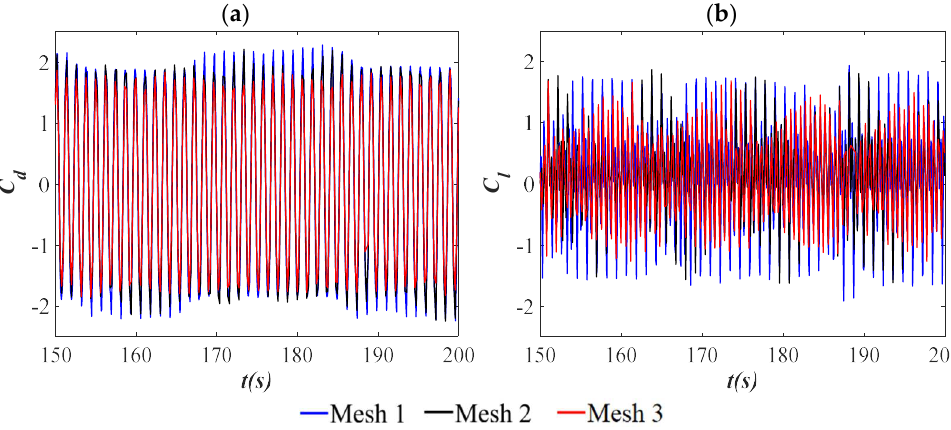
Figure 3. The time-histories of ( a ) C d and ( b ) C l for different meshes: Mesh 1: blue; Mesh 2: black; Mesh 3: red.